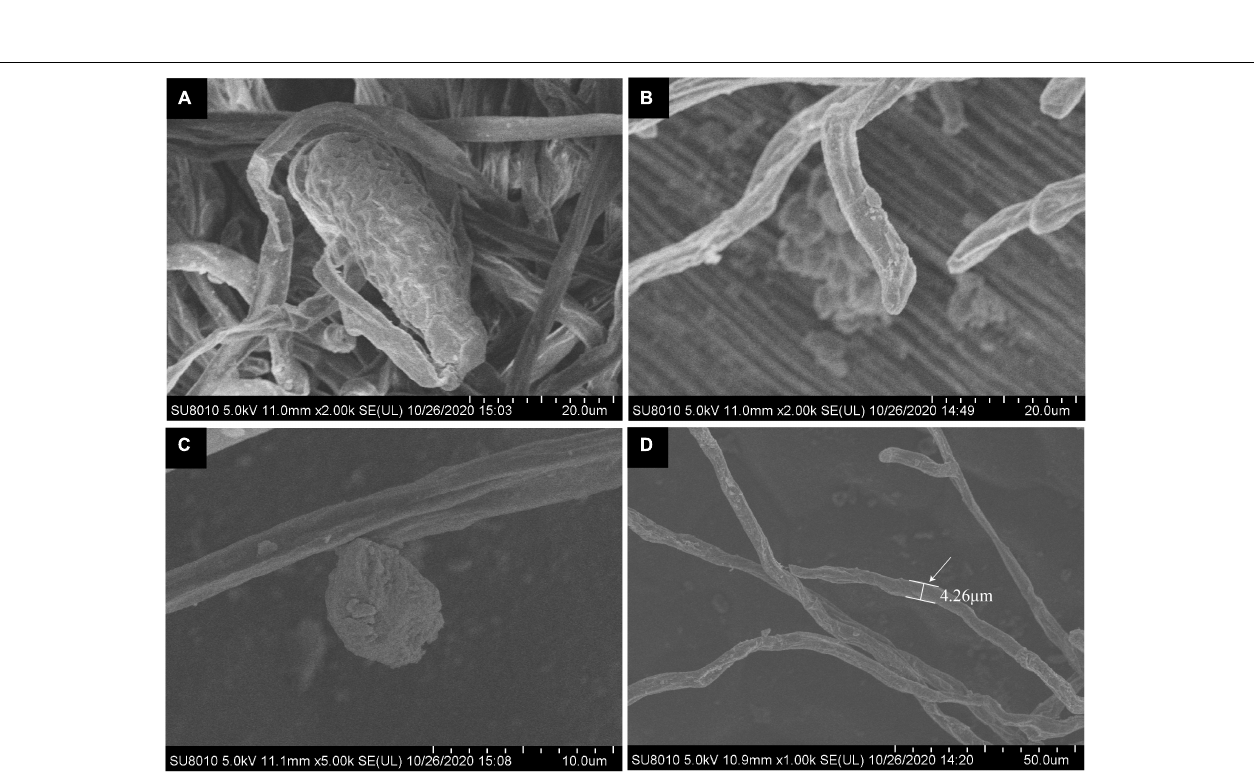
FIGURE 3 | Scanning electron microscopic (SEM) observation of G. artemisiae on A. selengensis . Conidia (A) , hyphae (B,D) , and hyphal appressoria (C) . The diameter of a hyphae is indicated by the white arrow.